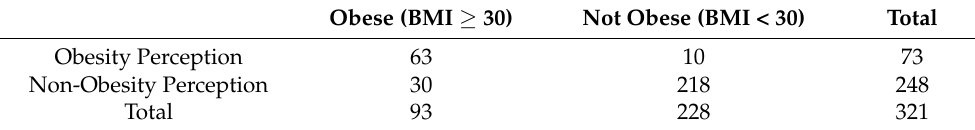
Table 4. Comparison between perception of one’s weight status and actual classification by BMI. Obese (BMI ≥ 30)